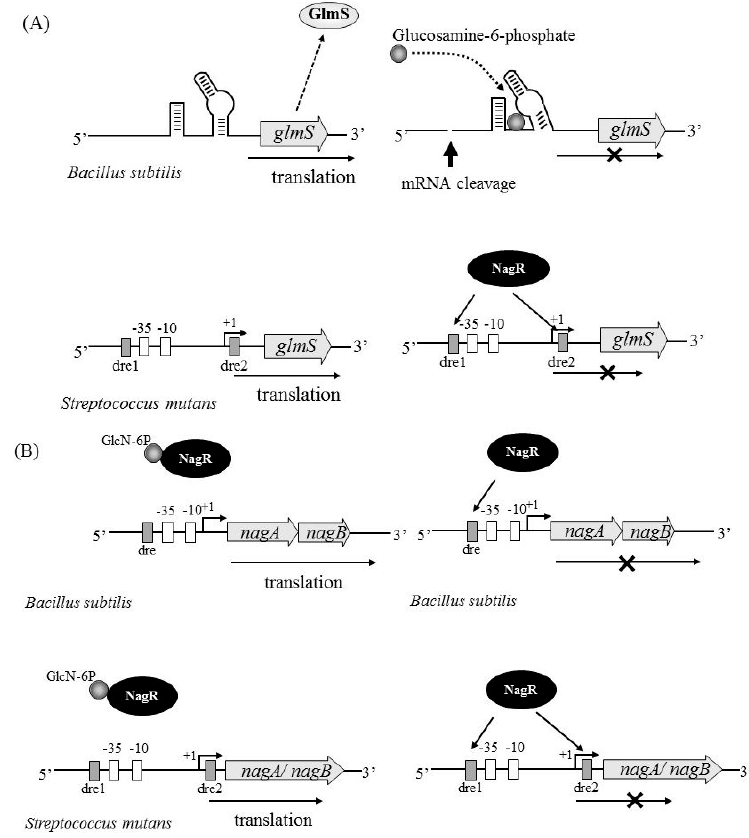
Figure 4. Regulation of glmS and nagAB expression in Bacillus subtilis and S. mutans . ( A ) The regulation of glmS in B. subtilis (upper) and S. mutans (lower) is shown. B. subtilis glmS transcript has ribozyme activity, which causes self ‐ cleavage in the presence of excess glucosamine ‐ 6 ‐ phosphate, a product of the GlmS reaction. GlmS of S. mutans is negatively regulated by NagR. NagR binds to the DasR responsive element (dre) sequence upstream of the glmS coding region, leading to inhibition of the glmS transcript; ( B ) Regulation of nagAB in B. subtilis (upper) and S. mutans (lower) is shown. In B. subtilis , nagA and nagB are tandemly located to form an operon, while nagA and nagB are independently located in S. mutans . NagR binds to the dre sequence upstream of nagAB in B. subtilis , leading to inhibition of the nagAB expression (upper right). However, NagR bound with GlcN ‐ 6P has no ability to bind to the dre sequence (upper left). The same regulation system is observed in nagA and nagB in S. mutans (lower left and right).